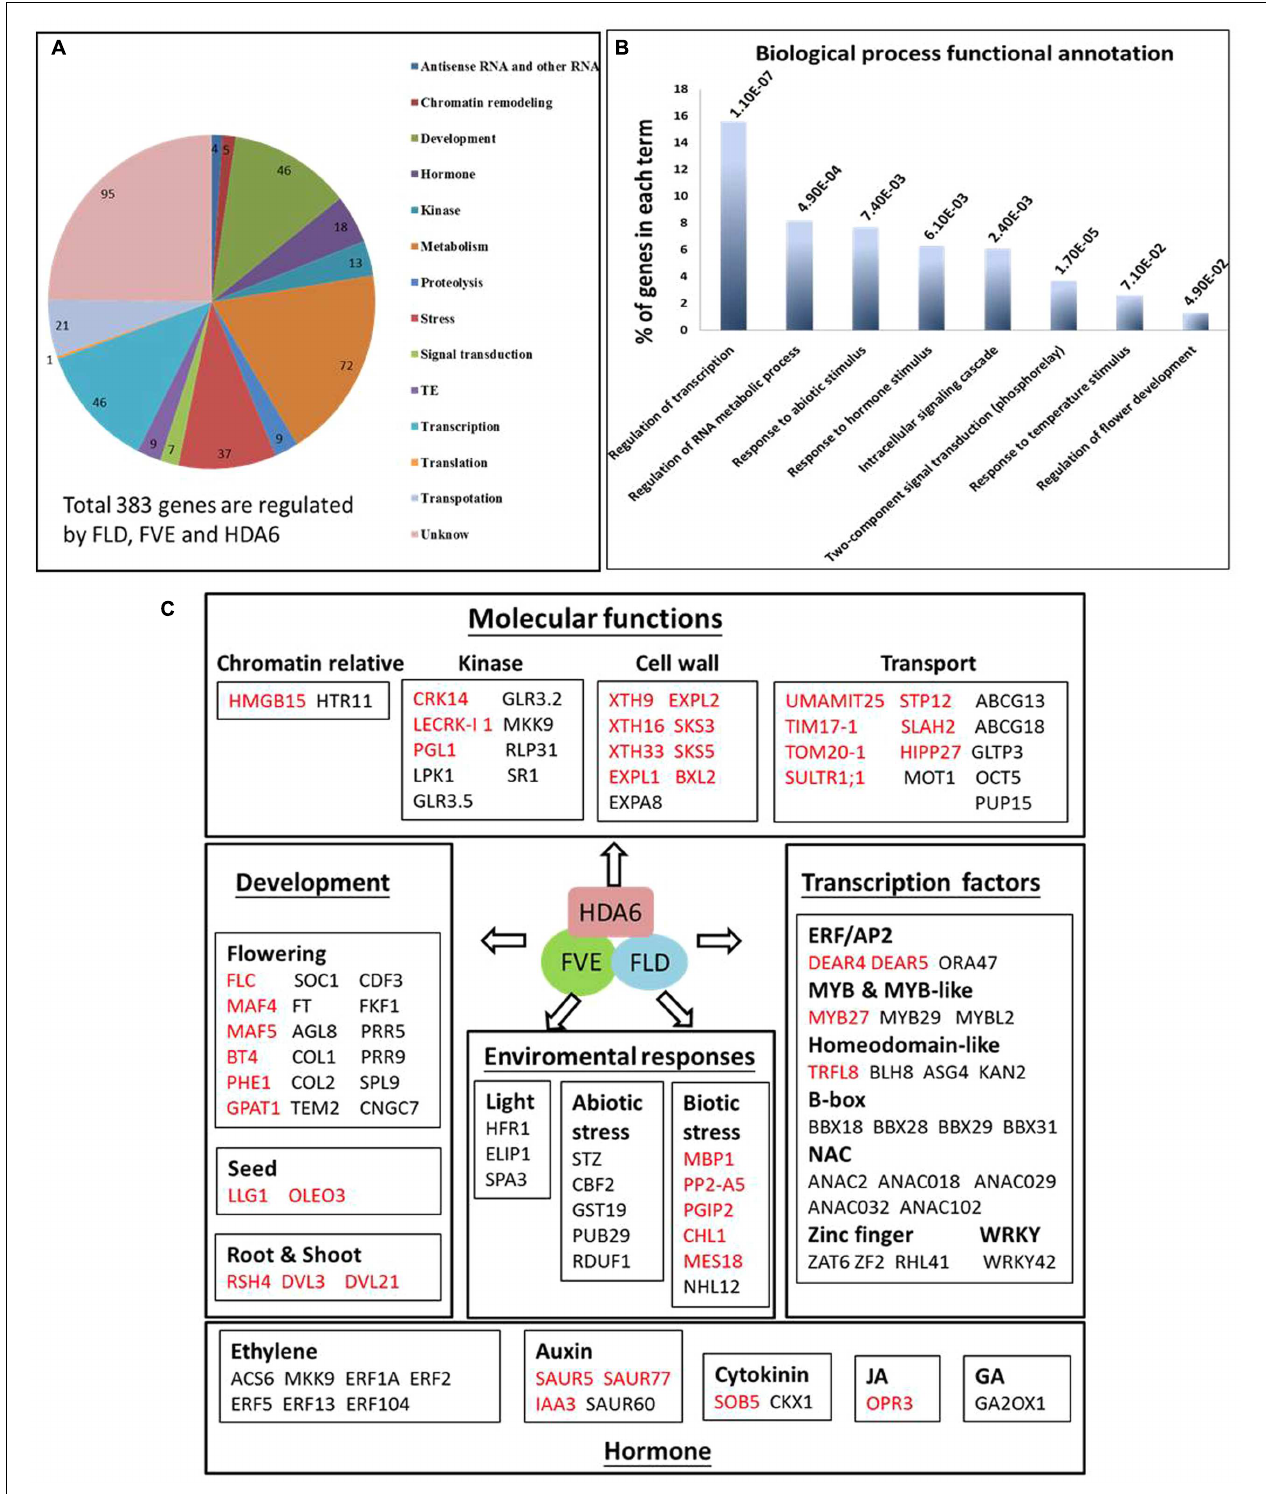
FIGURE 5 | Functional analysis of co-regulate genes in fve-4, fld-6, and hda6-6 mutants. (A) Gene Ontology classification of FVE, FLD, and HDA6 co-regulated genes. (B) DAVID functional clustering of the highly enriched GO terms in FVE-FLD-HDA6 co-regulated genes. (C) Representative FVE-FLD-HDA6 co-regulated genes with known functions in various molecular functions including development, enviromental responses, transcription regulation, and hormone responses. Genes repressed and activated by FVE-FLD-HDA6 are in red and black, respectively.